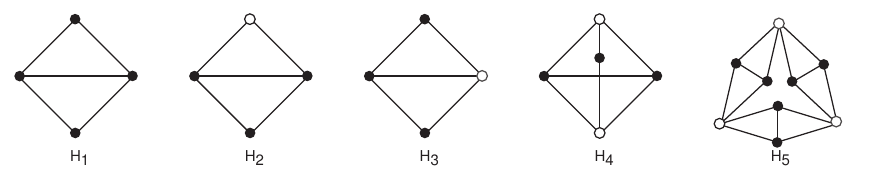
Fig. 1: Forbidden partitioned induced subgraphs for probe diamond-free graphs. Black vertices and white vertices represent probe vertices and nonprobe vertices,